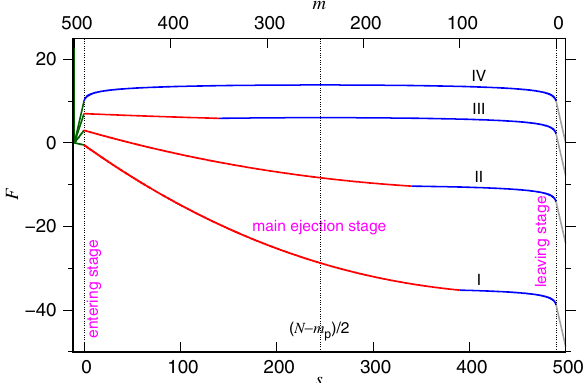
Figure 1. Free energy F as a function of the state variables s (the bottom axis) and m (the top axis). We choose 10 to draw the sketch. In the entering and the leaving stages, the free energy curves are N 500 and m p = = colored in dark-green and gray, respectively. In the main ejection stage, the curve is split into two sections: one in red color representing the confined stage and the other in blue color representing the non-confined stage. There exist four kinds of variations, denoted by I, II, III, and IV near the curves.